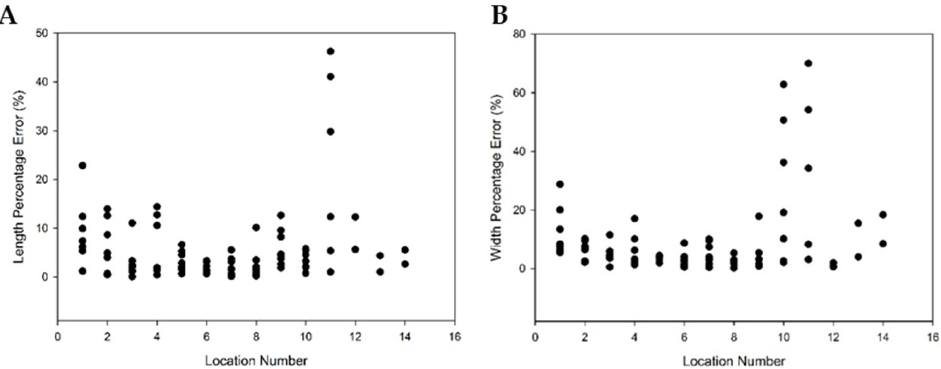
Figure 6. Percentage error by leaf position: ( A ) leaf length and ( B ) leaf width.